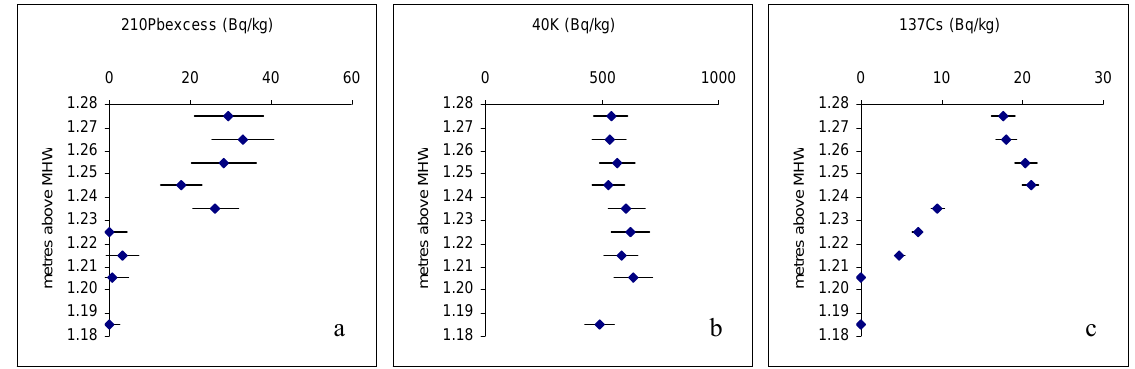
Fig. 8. Results of radiometric dating in trench 1, Kirra: variation in 210 Pb (a) , 40 K (b) and 137 Cs (c) with